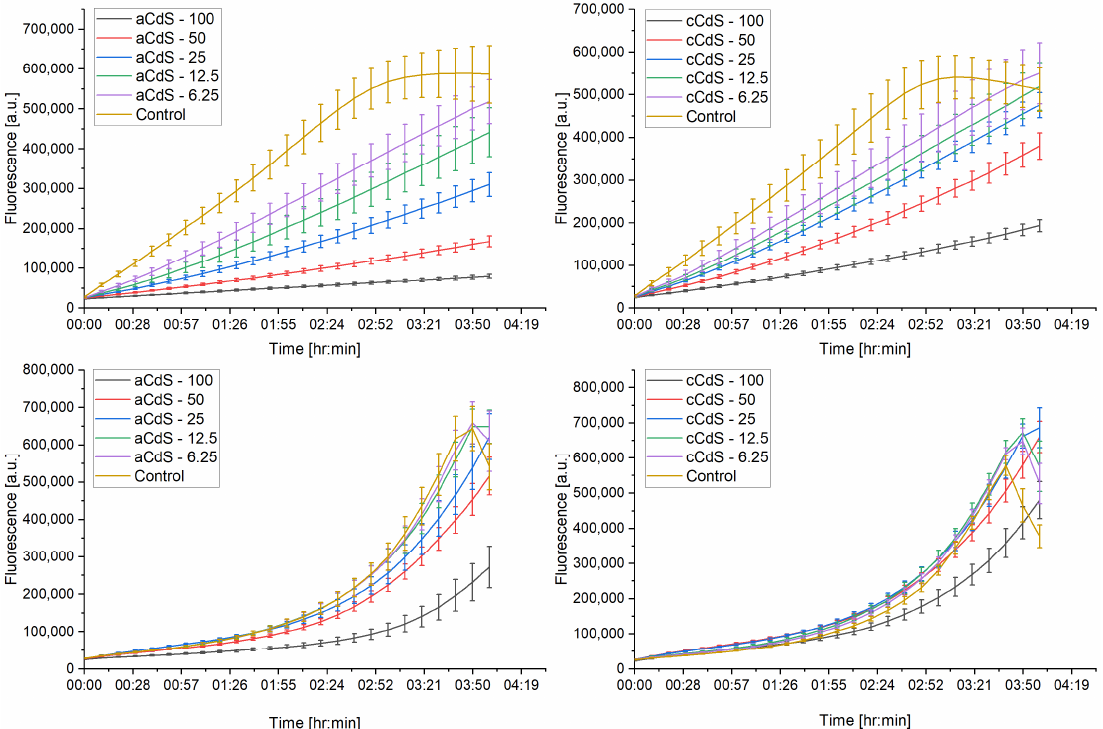
Figure 15. Respiration of cultures in the logarithmic growth phase in resazurin assay; S. aureus (first row) and E. coli (second row).